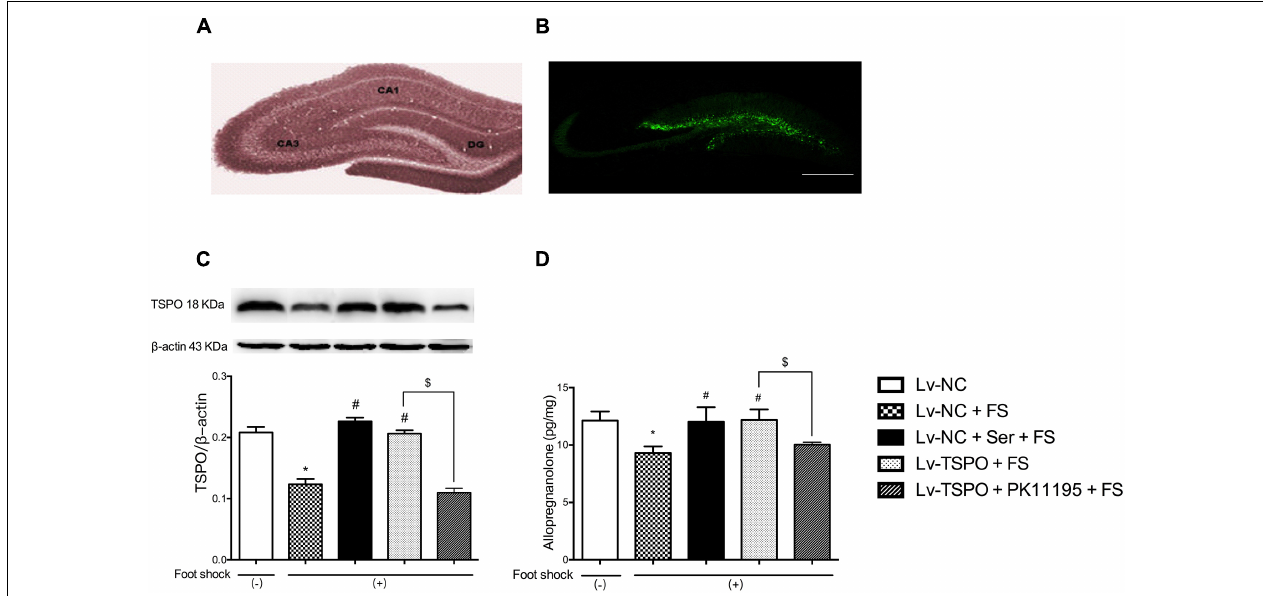
FIGURE 2 | Effects of lenti-GFP-TSPO on expression of TSPO and level of Allo in the DG of mice. (A,B) Fluorescence microscopy captured the microinjection sites shown as expression of GFP in the DG; Scale bars = 500 mm; n = 3. (C) Representative immunoblots of TSPO and the histogram represents semi-quantitative results of western blot analysis. The protein expression of TSPO were normalized by β -actin; n = 3; (D) The level of Allo of hippocampal tissues; n = 3. Data were presented as the means ± SEM. ∗ P < 0.05 compared with the Lv-NC+foot-shock (–) group; # P < 0.05 compared with the Lv-NC+FS group; $ P < 0.05 compared with the Lv-TSPO+FS